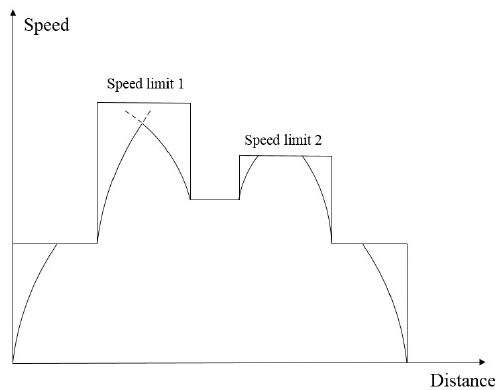
Figure 5. Speed profile with minimum trip